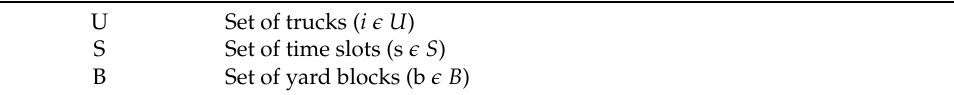
Table 2. Sets used in the proposed